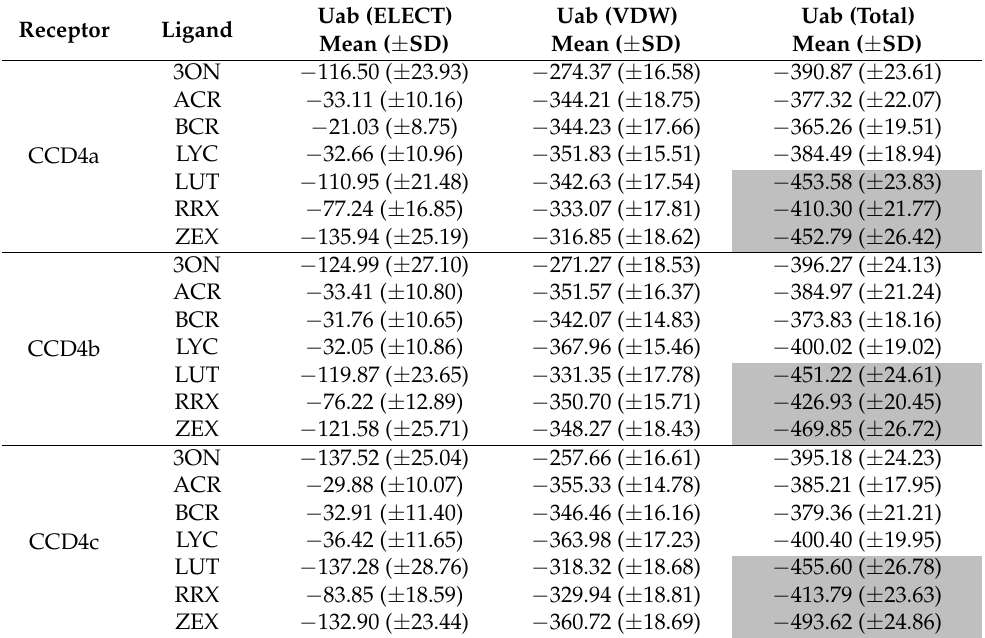
Table 3. Values of the total interaction energy (Uab) and van der Waals and electrostatic components averaged for all complexes. Average values are evaluated as a function of time for all trajectories. Best interaction energy values are highlighted in grey. All values are in kJ/mol. Abbreviations 3ON: 3-hydroxy-8 (cid:48) -apocarptenol; ACR: α -carotene; BCR: β -carotene; LYC: lycopene; LUT: lutein; RRX: β -cryptoxanthin; ZEX: